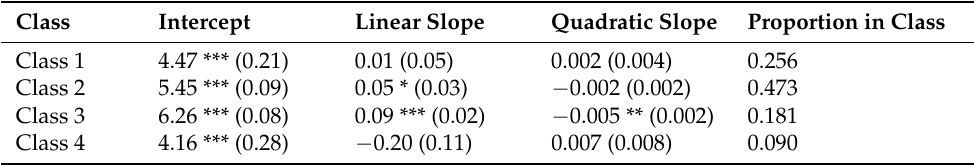
Table 5. Parameters of Latent Growth Curve Models for the 4-class solution (means and standard